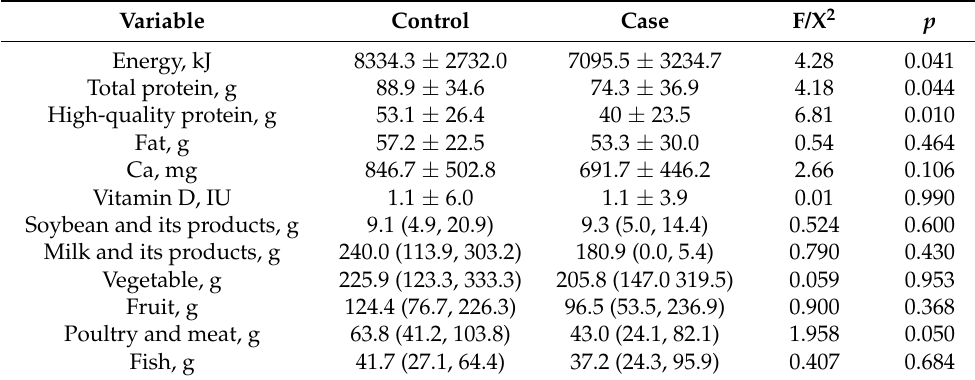
Table 2. Comparison of dietary intake between the control and case groups.